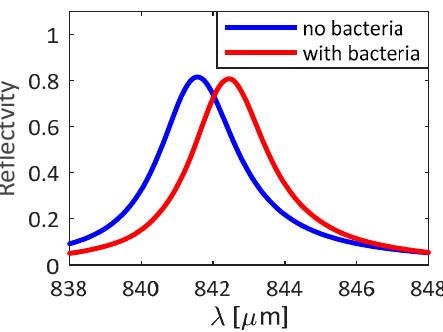
Figure 3. Reflection spectra for the case without bacteria (blue curve) and with bacteria (red curve) on the GMR structure. Spectra calculated by 3D FEM approach.